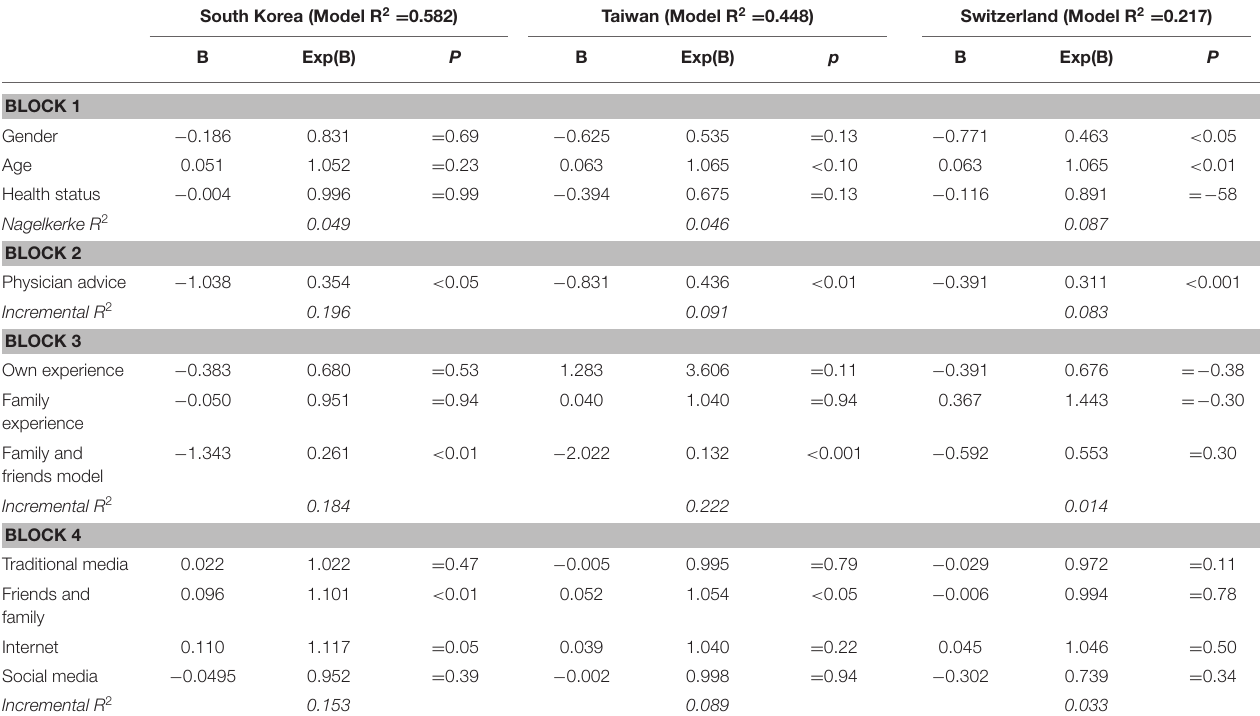
TABLE 3 | Prediction of vaccination behavior by physician advice, experience, and reception of vaccination-supportive information from different sources (binary logistic